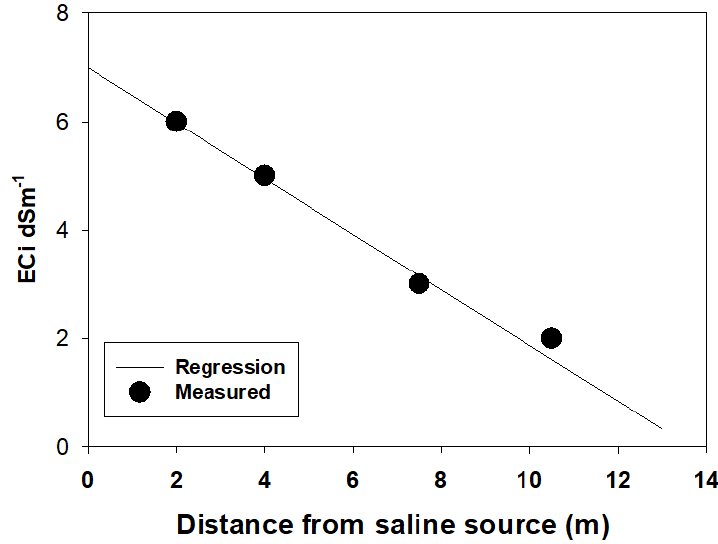
Figure 1. Changes in irrigation water salinity (ECi) as a function of distance from the saline source line: Regression Equation (6).